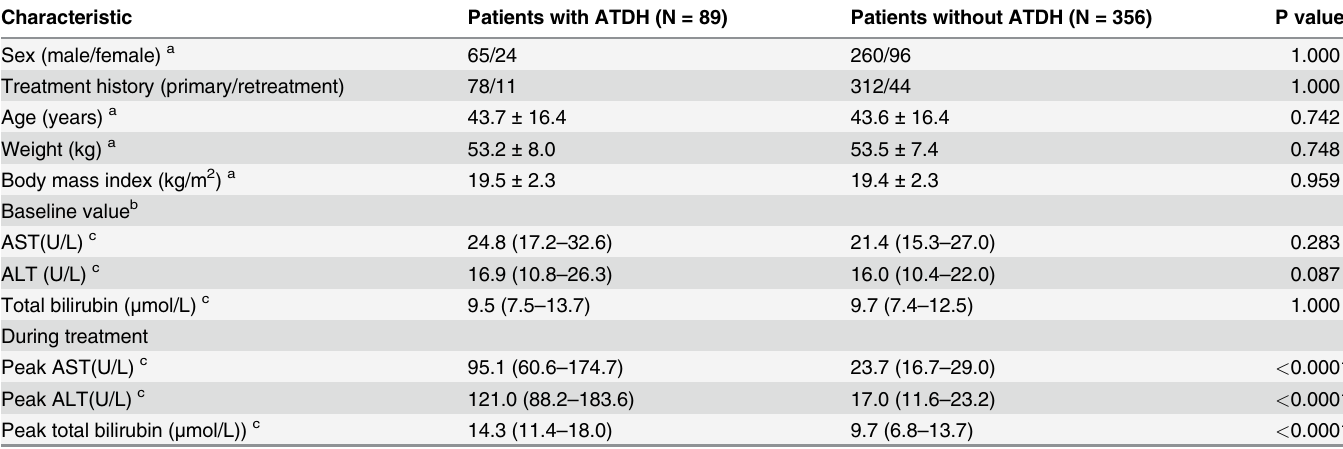
and control groups were presented in Table 3. The conditional logistic regression analysis